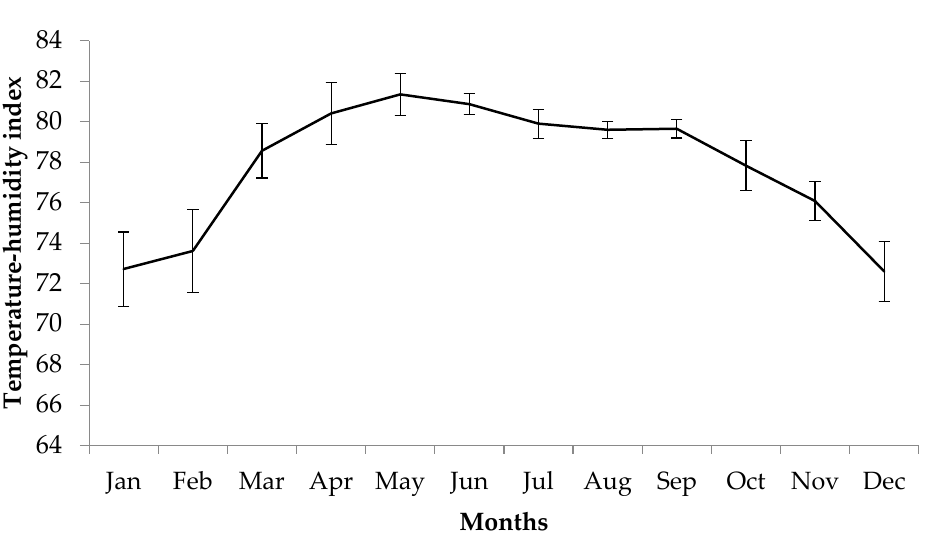
Figure 3. Average temperature-humidity index in Khon Kean province, Thailand, during 2015–2020.